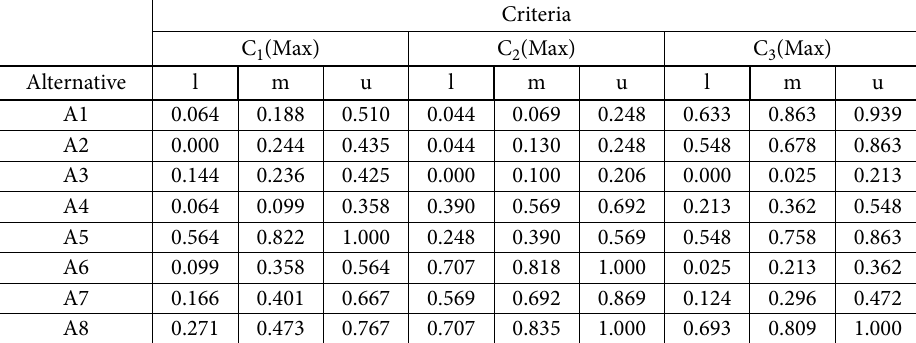
Table 9. Normalized fuzzy decision